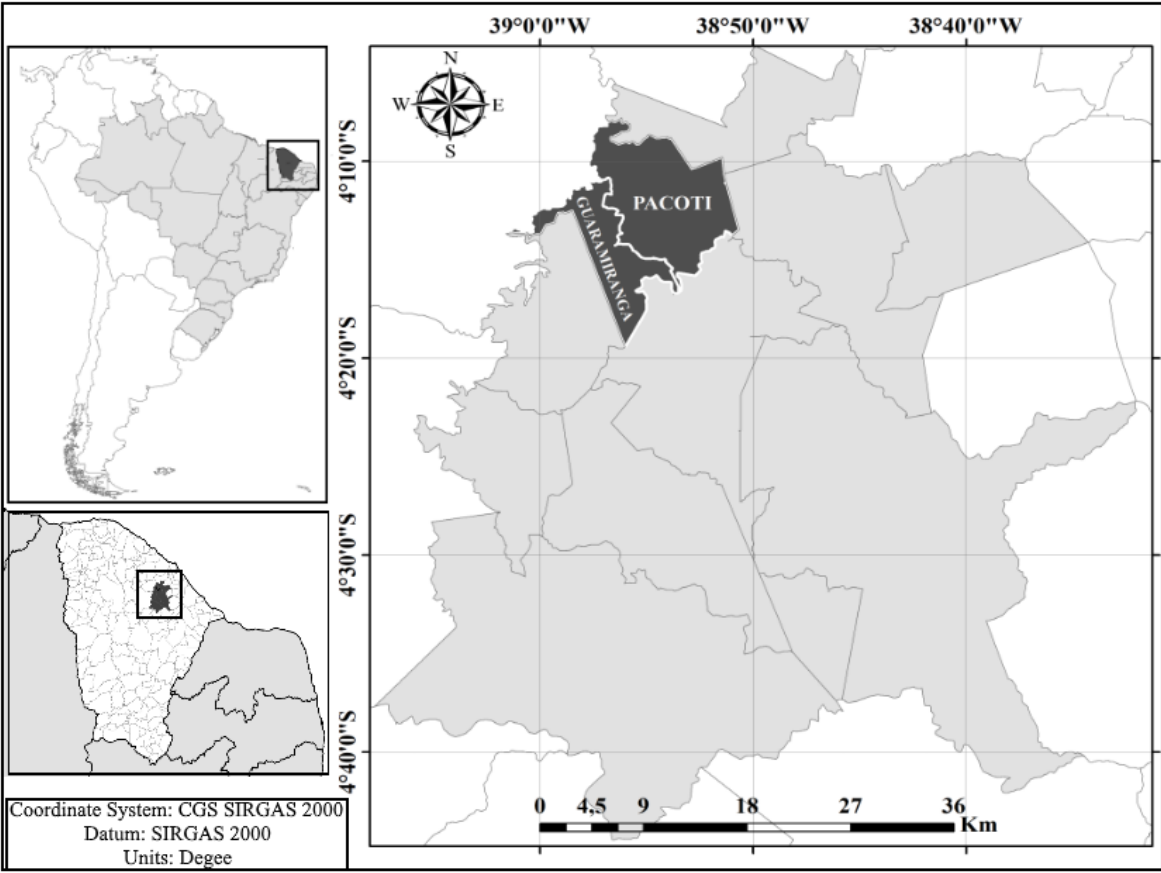
Figure 1. Location of the studied municipalities regarding the nesting biology of solitary bees in the State of Ceará, highlighting the region of the Baturité Massif and the two municipalities studied (Guaramiranga and